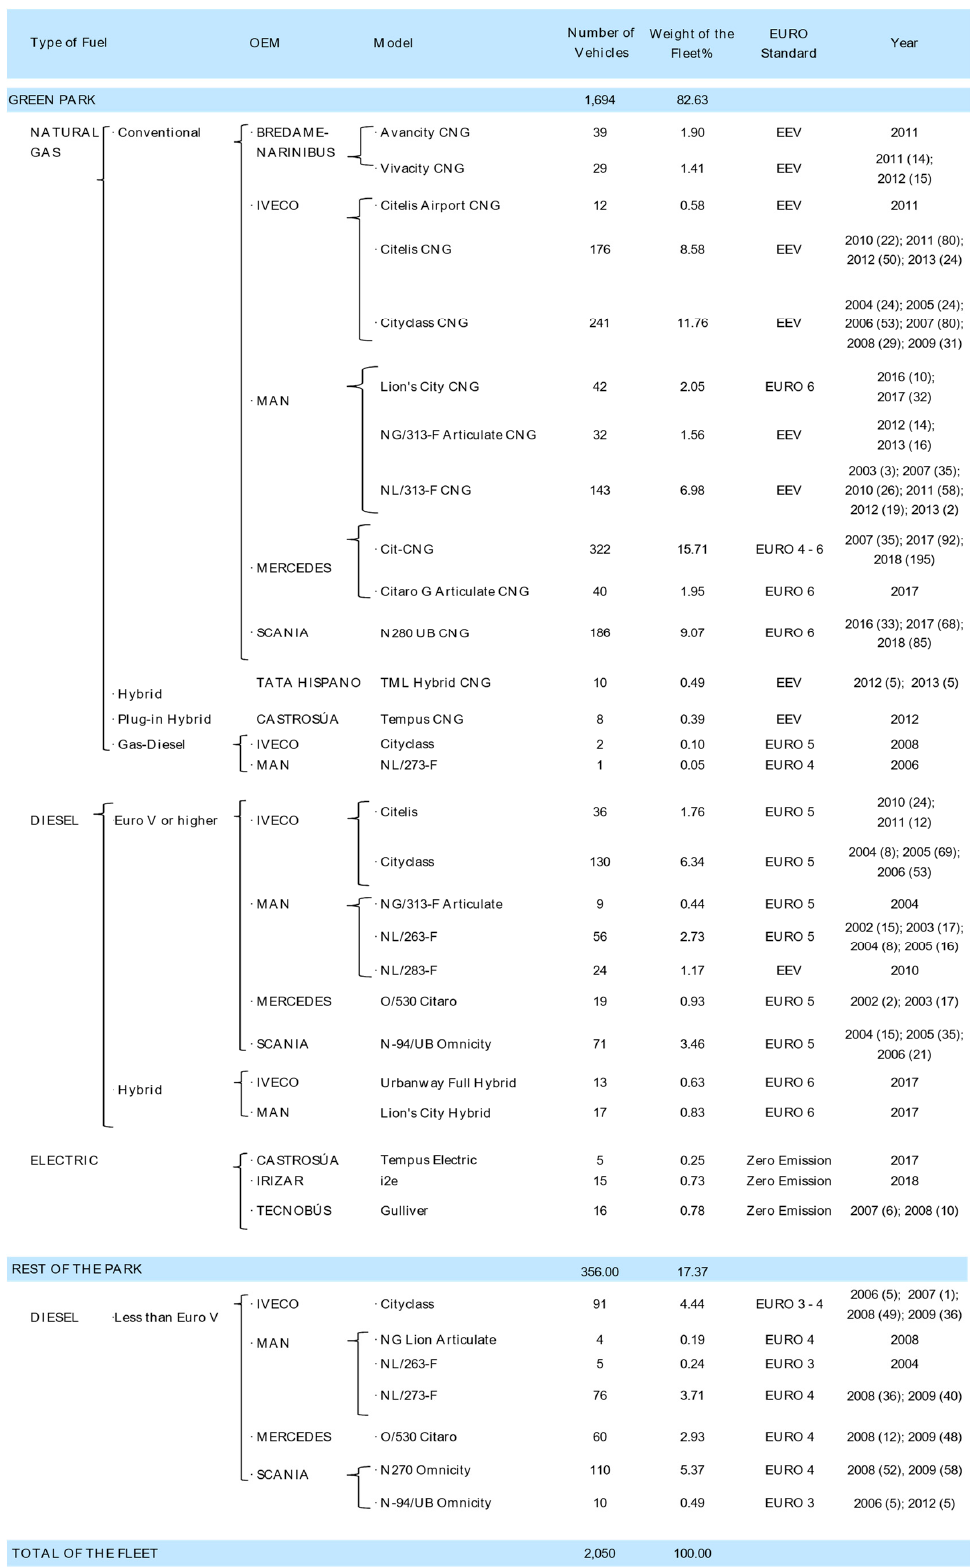
Figure 13. EMT (Madrid Municipal Transport Company) urban bus fleet.